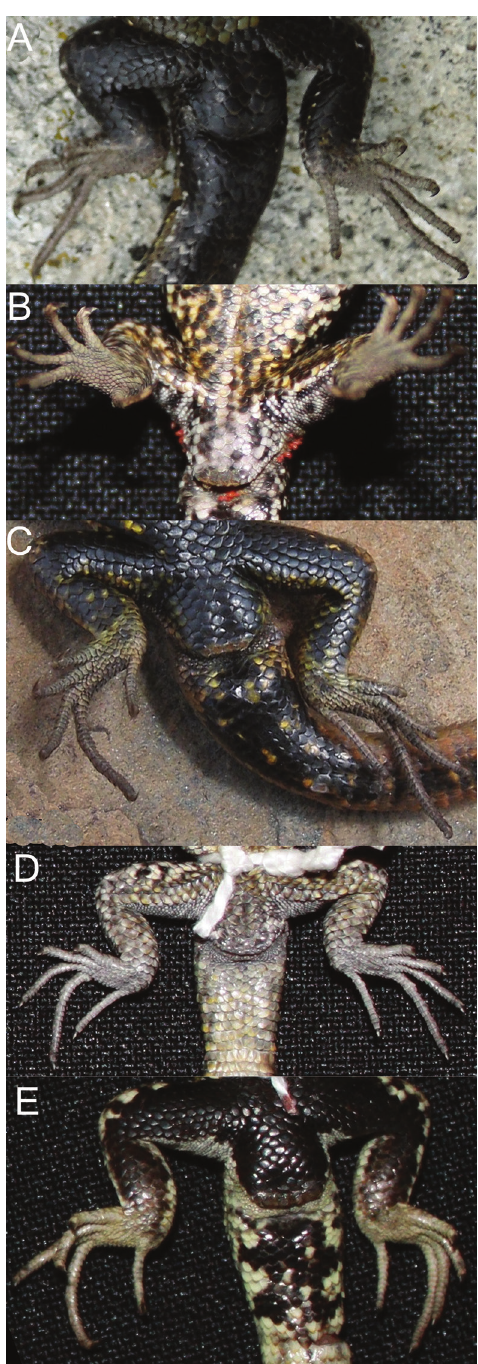
Figure 2. Detailed view of the cloaca region showing absence ( a, D ) or presence ( B, C, e ) of precloacal pores: a Ancash B Ayacucho C Cusco D L. tacnae and e L. walkeri